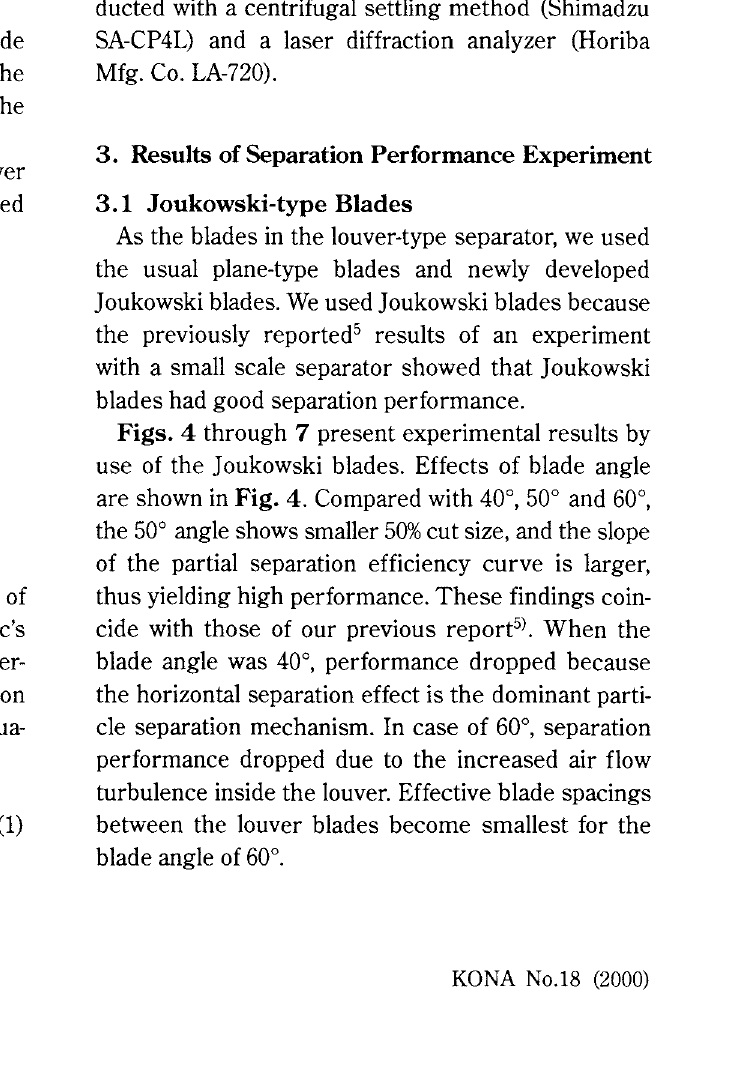
Fig. 2 Photograph of Louver Classifier Fig.